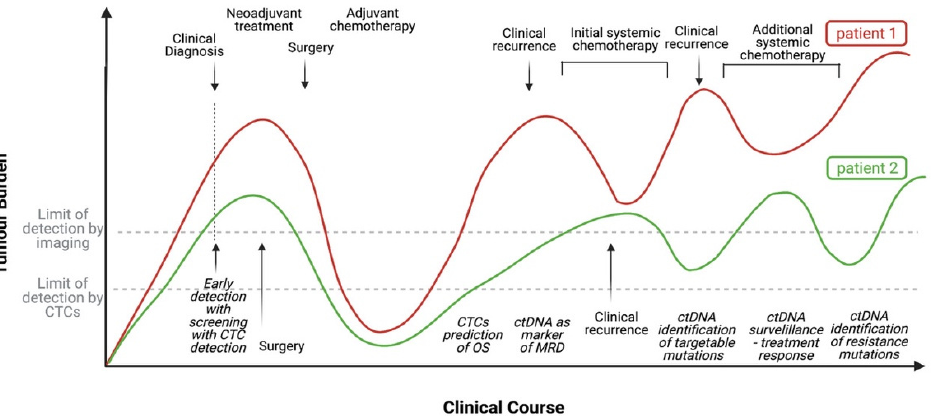
Figure 2. Graph demonstrating the potential roles of ctDNA and CTCs in the clinical course of a patient with NSCLC compared with standard approaches to patient care. Patient 1 demonstrates standard approaches to screening, diagnosis and monitoring of a patient with NSCLC. Patient 2 demonstrates the potential utility of ctDNA and CTCs in the disease course of a patient with NSCLC.